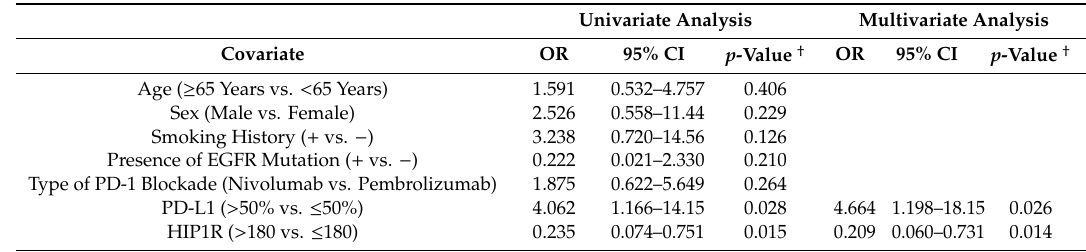
Table 2. Univariate and multivariate logistic regression analysis for predicting clinical response to PD-1